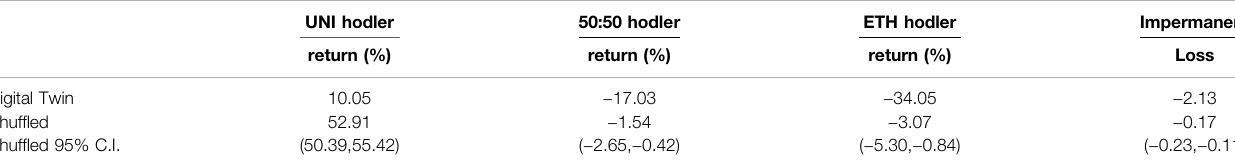
TABLE 5 | Strategy returns and Impermanent